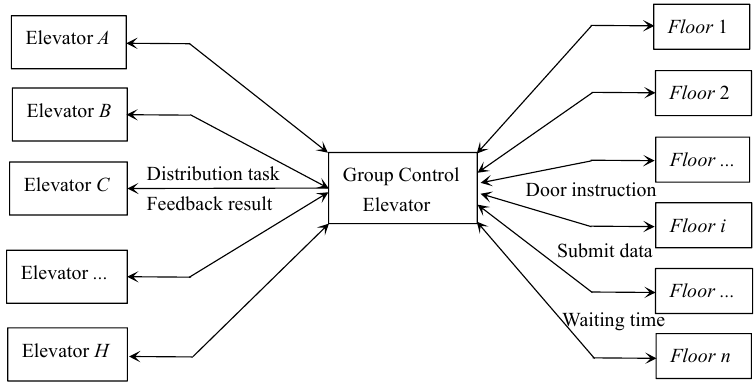
Figure 4. Elevator group internal control and reservation data